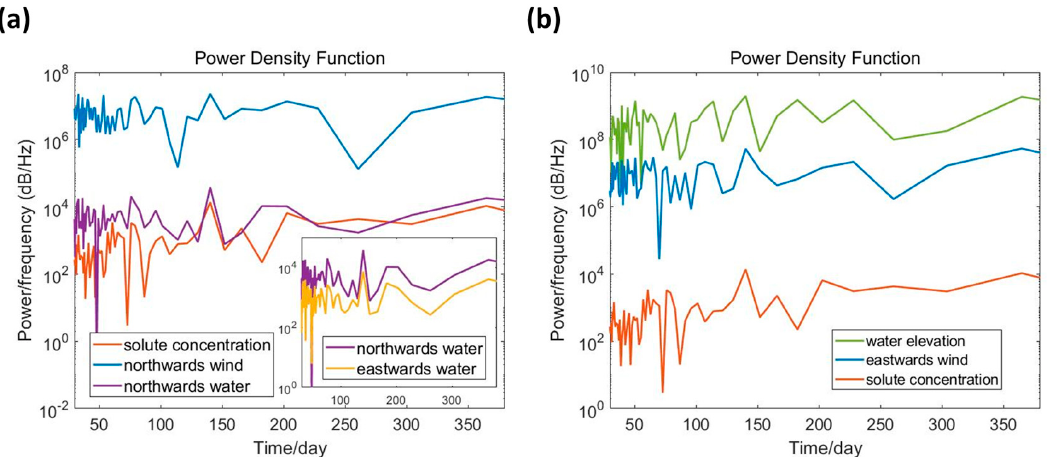
Figure 4. Power spectral density (PSD) analysis for the Kalmar County coast case. ( a ) PSDs of relatively strongly correlated variables; ( b ) PSDs of weakly correlated variables.